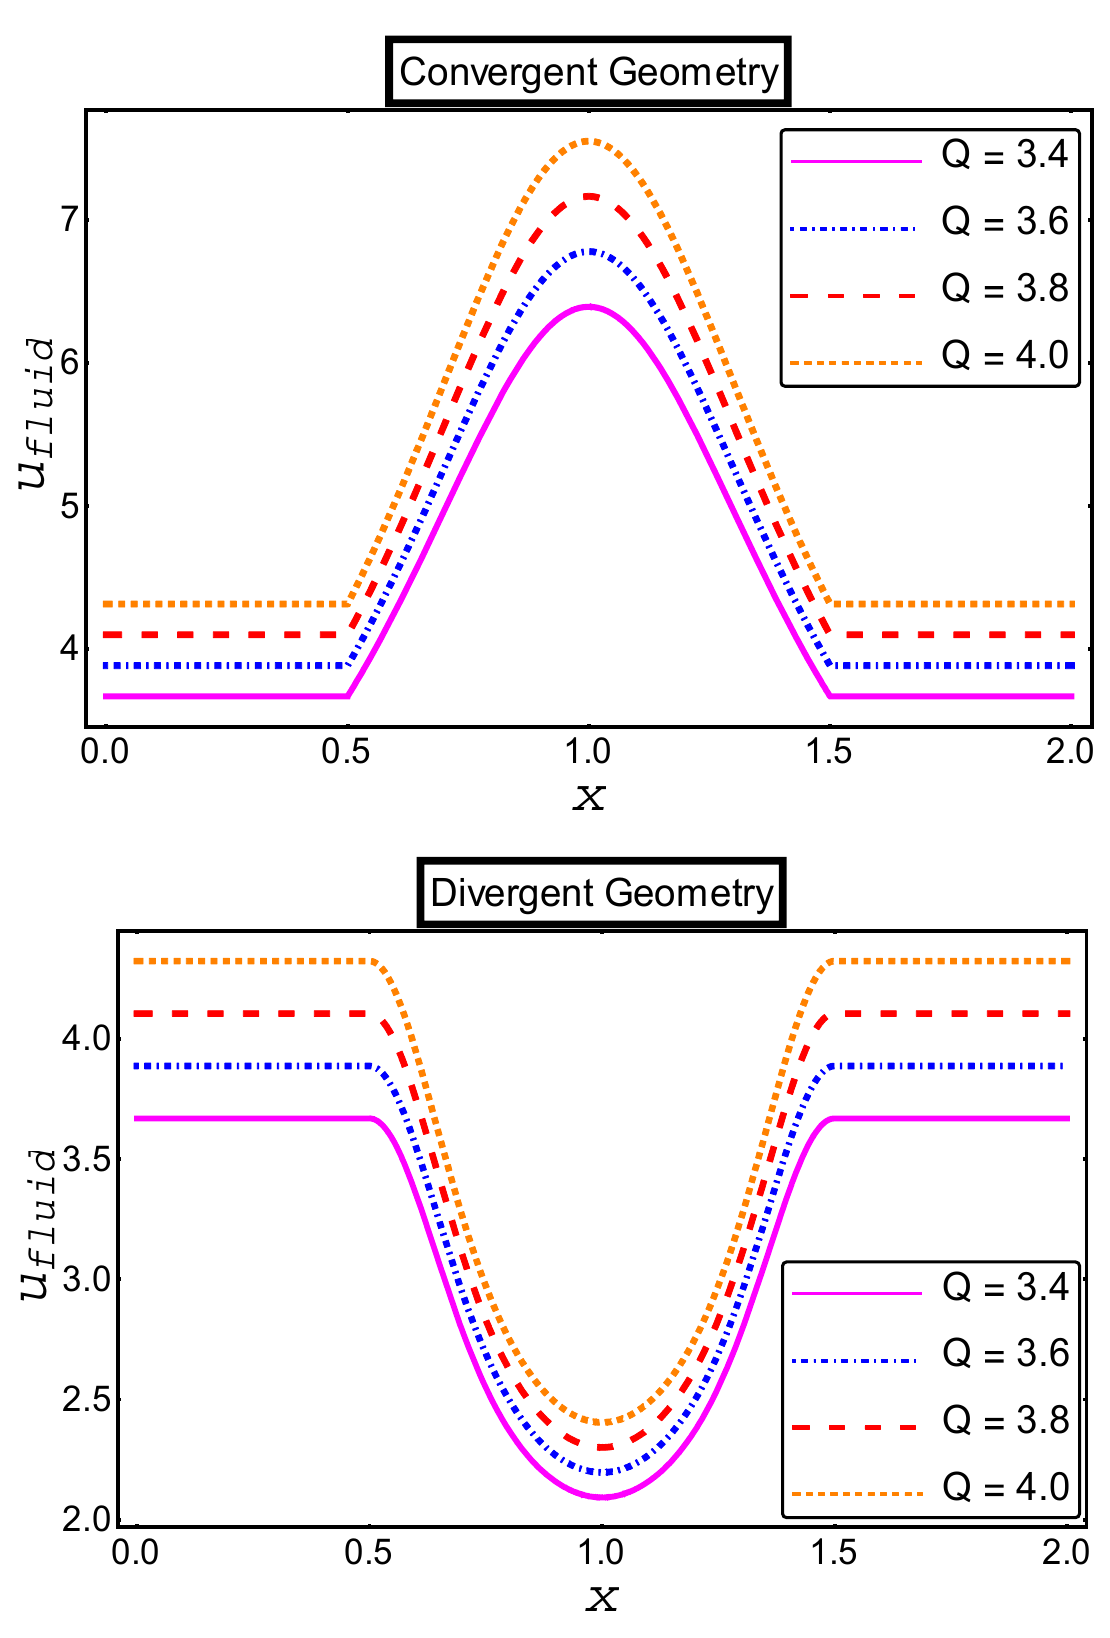
Figure 9. Impact of volumetric fl ow rate on fl uid velocity.